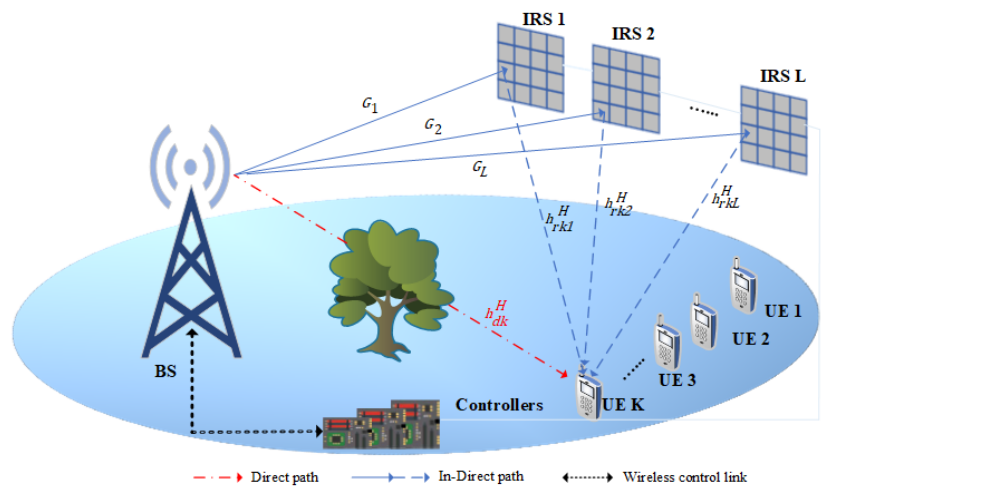
Figure 1. Architecture of IRS-aided